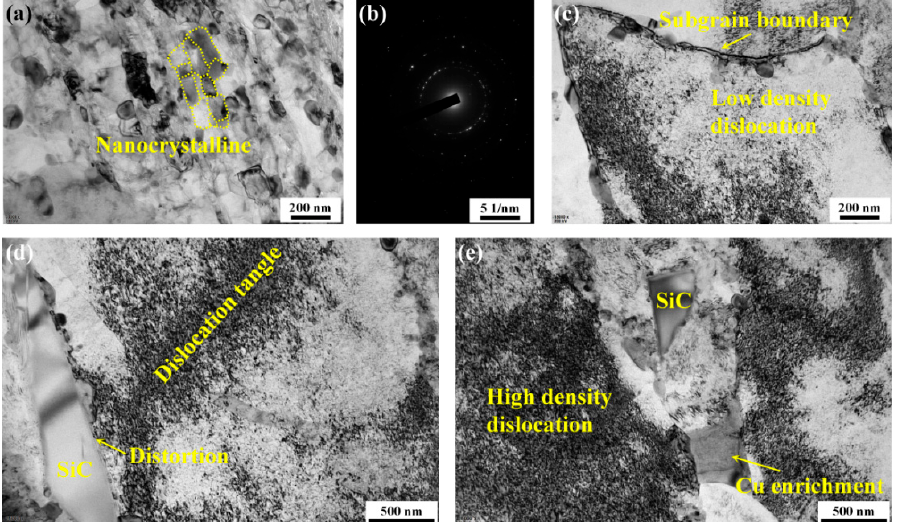
Figure 4. Typical TEM images illustrating microstructural morphology of aluminum substrate in the TLSPed-30 J specimen. ( a ) Nanocrystals generated on the peened surface, ( b ) corresponding SAED pattern of concentric rings, ( c ) low density of dislocation, ( d ) dislocation tangles and distortion at the SiC/Al boundary and ( e ) high density of dislocations.